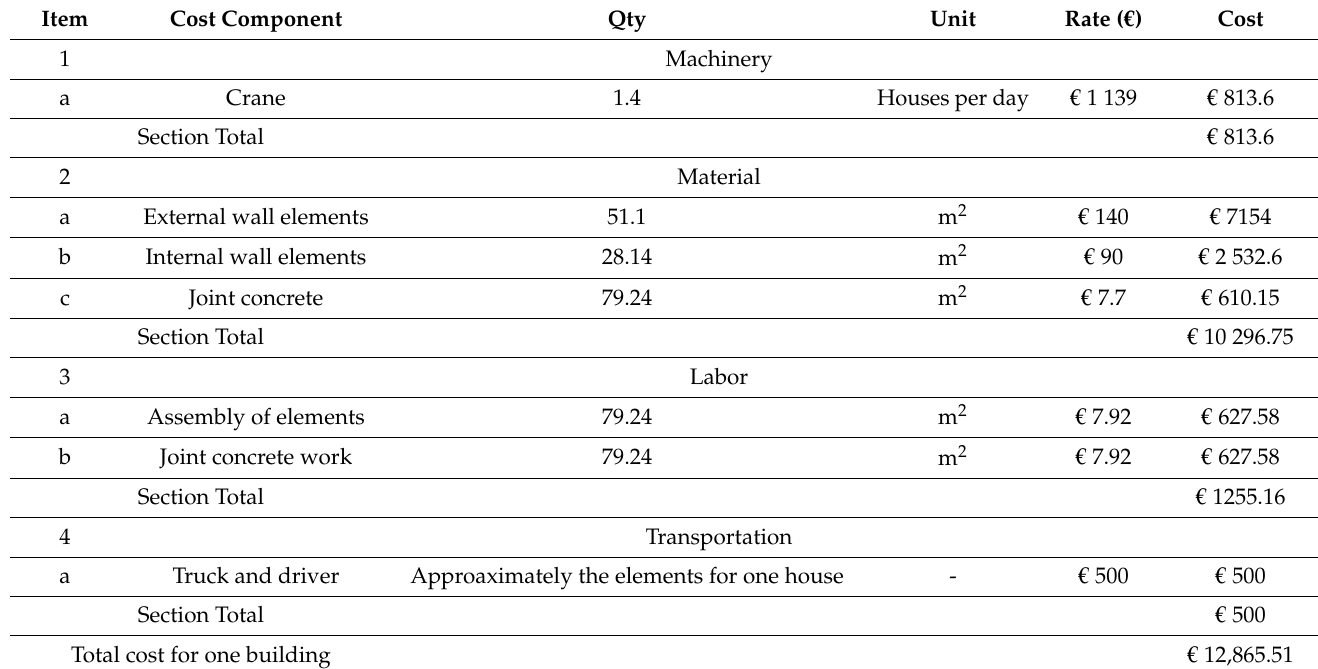
Table A8. Scenario 7 cost model in